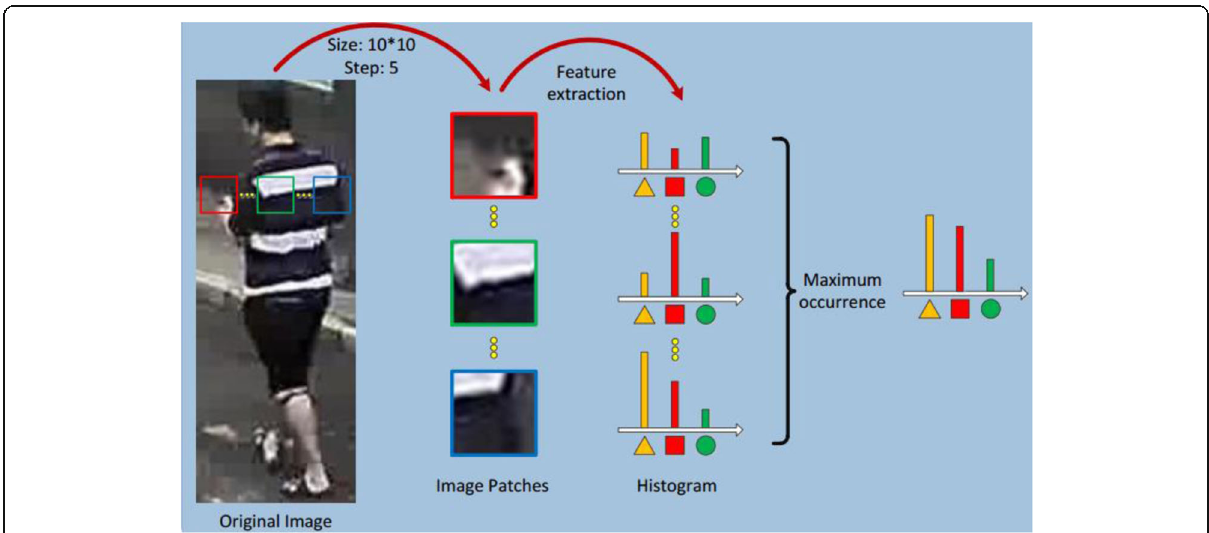
Fig. 11 Illustration of the LOMO feature extraction method